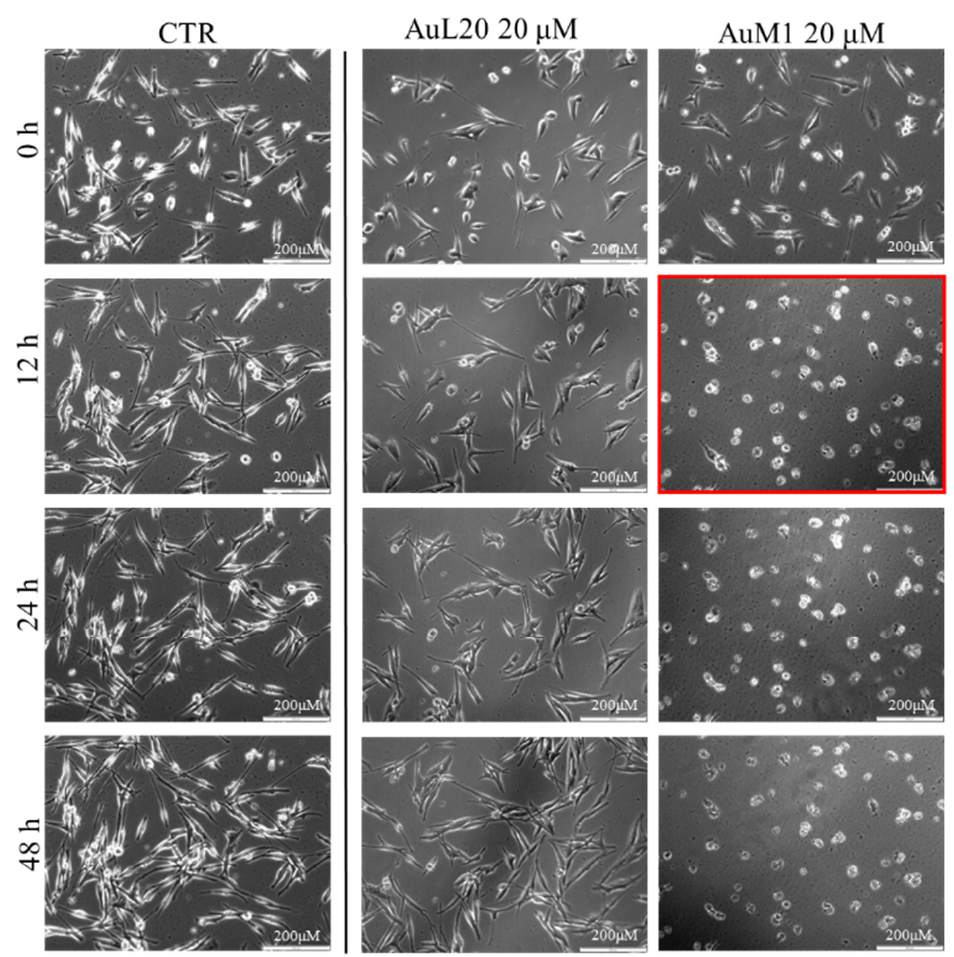
Figure 5. Cell viability of MeWo cells treated with 20 μ M of each metallic complex for 48 h of cells monitored by Time-lapse Live-Cell Imaging System assay.